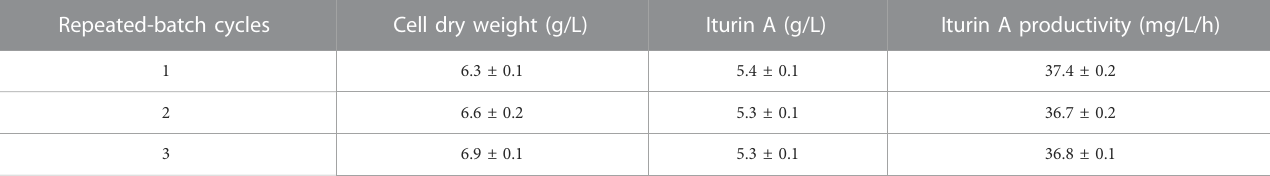
TABLE 2 Comparison of parameters in each cycles. Repeated-batch